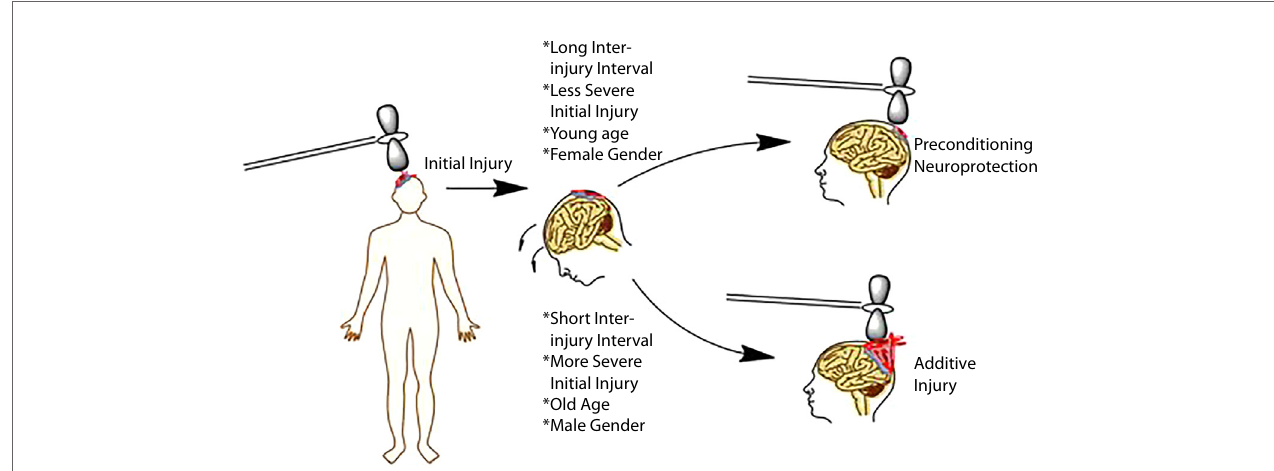
FiGURe 2 | Schematic representation of factors influencing injury outcomes, particularly in repetitive injury paradigms . Initial evidence indicates that longer inter-injury intervals, less severe initial injury, a younger age, and female gender may serve as protective effects in repeat paradigms. By contrast, shorter intervals, increased severity, older age, and male gender may be associated with worse